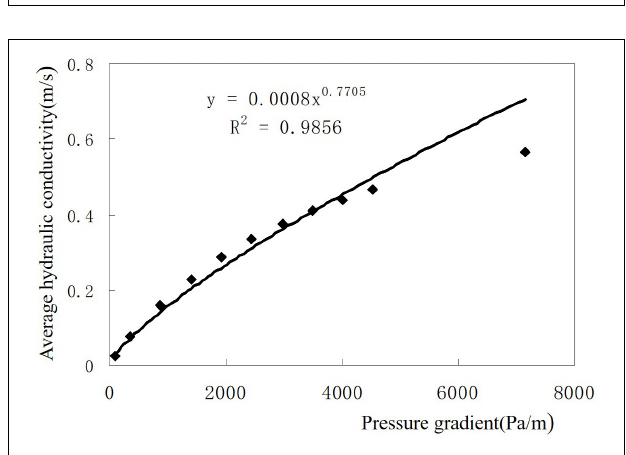
FIGURE 6 | The relationship diagram between the average hydraulic conductivity and pressure gradient.